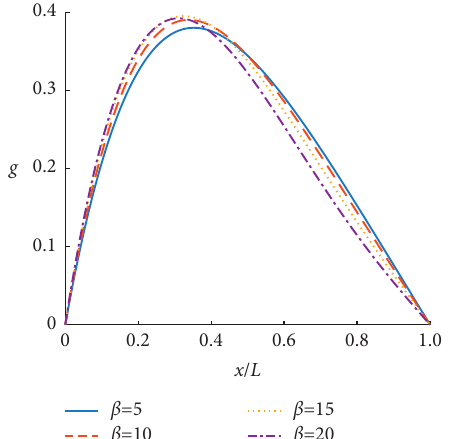
Figure 14: Influence of the parameter β on the equivalent couple amplification factor at different locations of the